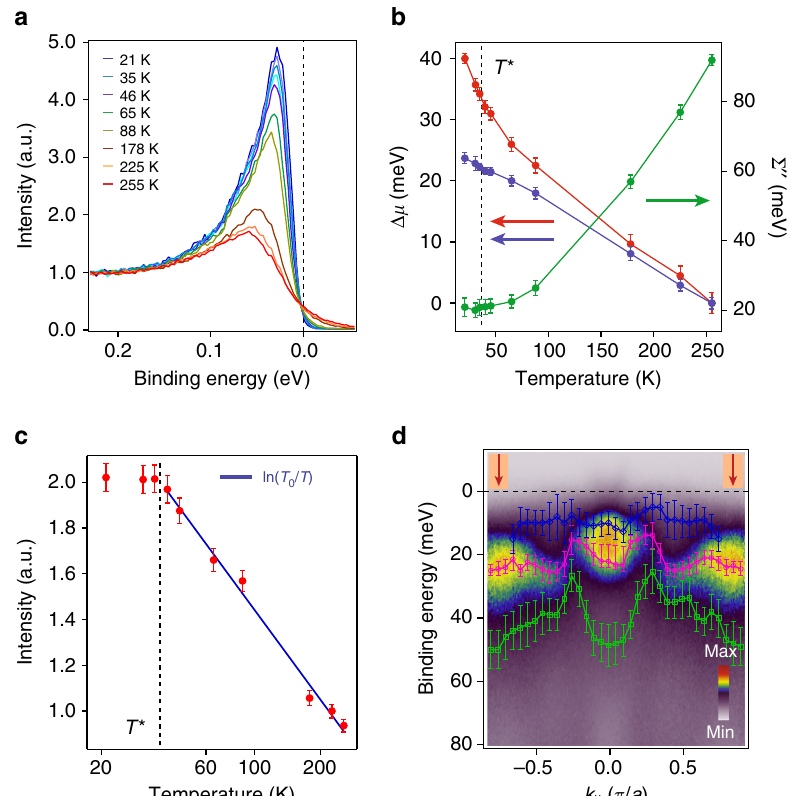
Fig. 3 Evolution of the Yb 4 f states and crystal fi eld effects in YbAl 3 . a Evolution of the Kondo resonance peak with temperature, from integrating EDCs over k region highlighted as red in d . b Change in the chemical potential ( Δ μ ) and in the 4 f quasiparticle scattering rate with temperature. Δ μ is estimated from the shift in binding energy of the 4 f -derived heavy band (blue) and the band bottom of the light electron-like pocket at (0, 0) (red) relative to 255 K. Error bars represent uncertainty due to statistical error of one standard deviation from the fi tting process. c Temperature dependence of the integrated spectral weight (0 – 0.2 eV) of the 4 f states which show a ln( T 0 / T ) behavior above T * = 37 K. Error bars represent 3% margin of error. d High resolution E vs. k plot along (0, 0) – (0, π ) at 21 K showing dispersive crystal electric fi eld (CEF) split states. Extracted dispersions of the three different CEF split states (shown in blue, pink and green) are superimposed on the image plot. In addition to statistical error of one standard deviation from the fi tting process, error bars in d , also include variability in the fi t results by holding one and/or two peak positions constant in the multi-peak fi tting